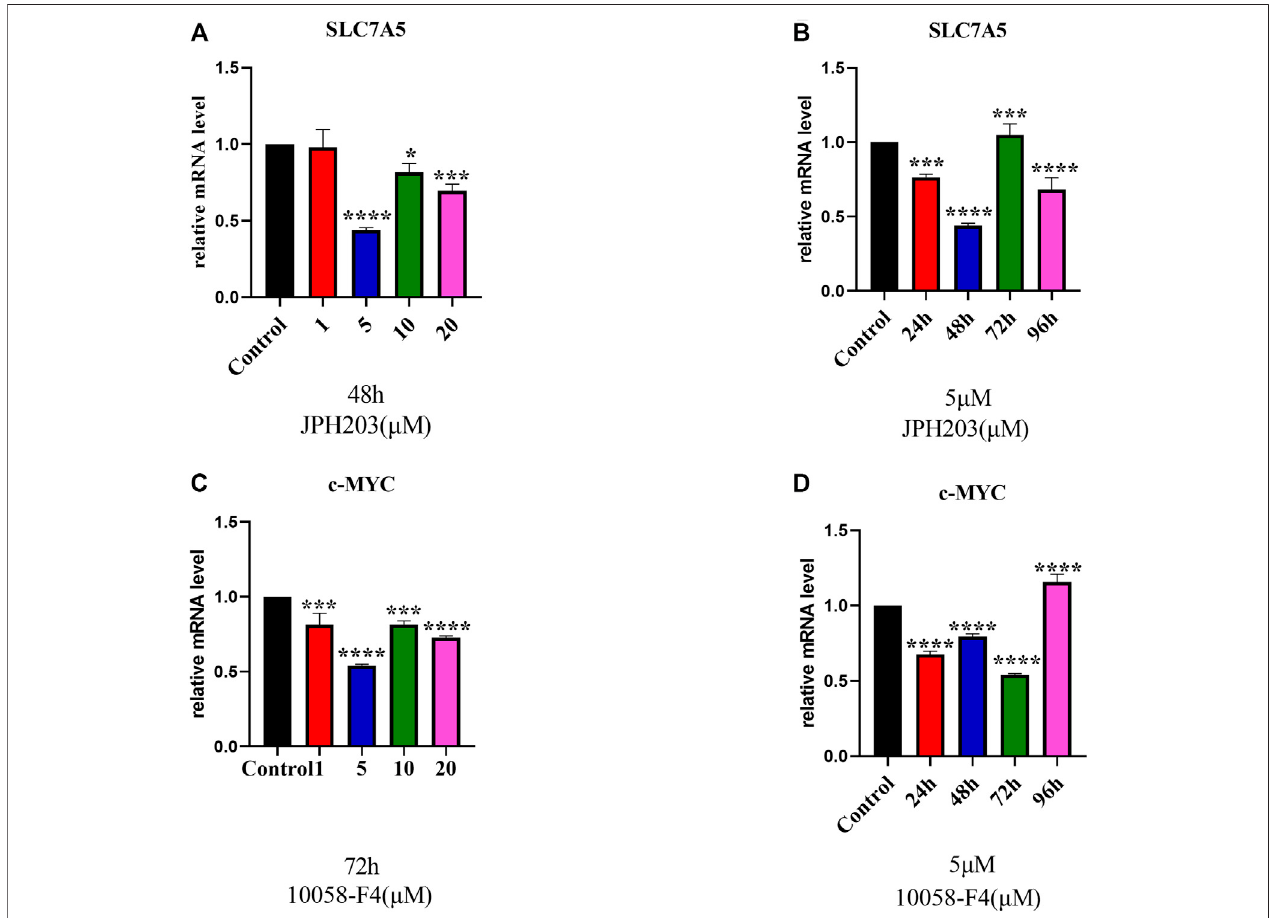
FIGURE 4 | RT-qPCR evaluation of SLC7A5 (A, B) and c-MYC (C, D) gene expression. hBMSCs were cultured in the osteogenesis induction medium and then treated 10058-F4 and JPH203 with different concentrations (0, 1, 5, 10, 20 μ M) and for different time periods (0, 24, 48, 72, 96 h). GAPDH was used as an internal control. Data arepresented asthe mean ± SEM, Concentration groups vs. the control group; time-point groups vs. thecontrol group. Experiments were repeated three times. * p < 0.05, ** p < 0.01, *** p < 0.001, **** p < 0.0001.